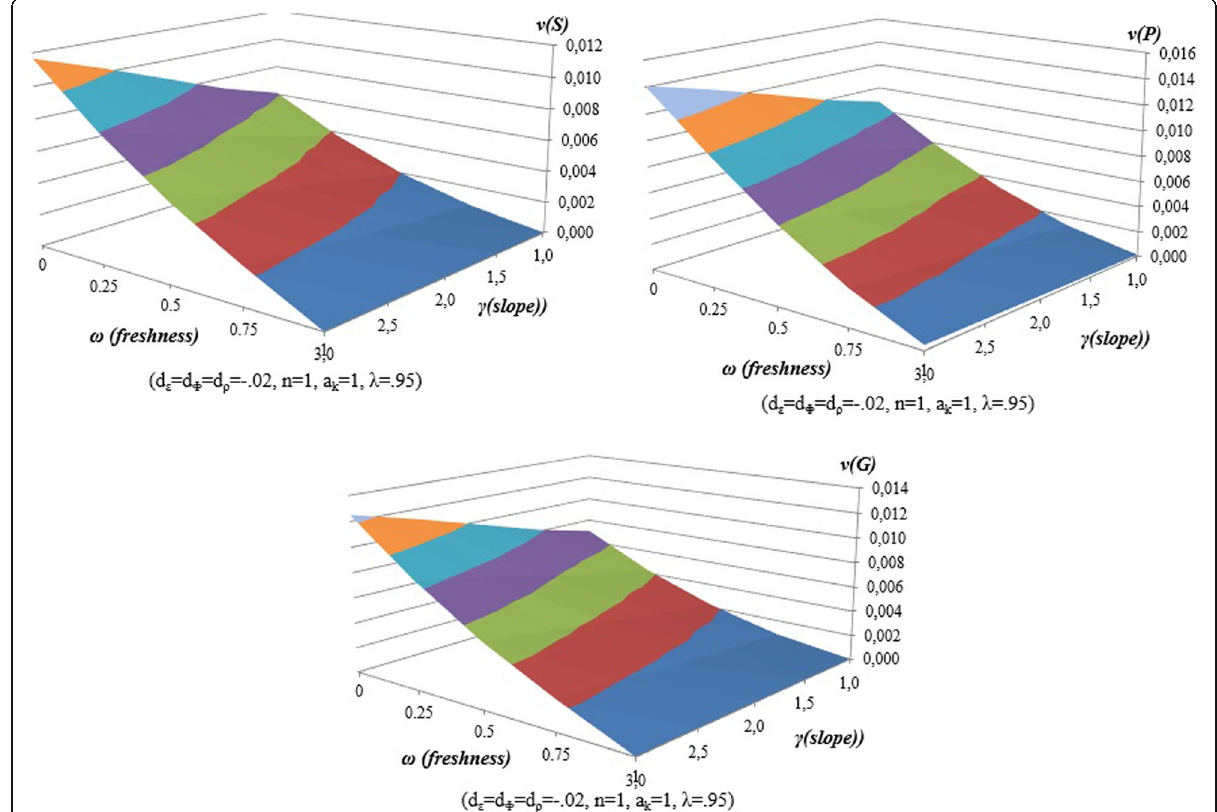
Fig. 3 Upper bounds of security v(A S ), privacy v(A P ) and service v(A G ) risks for various slope ( γ ) and freshness ( ω